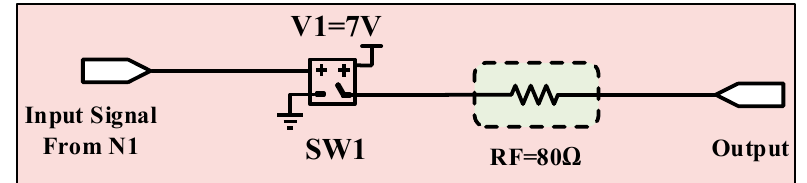
Figure 4. The first modeled synapse as a resistor and threshold-dependent switch.